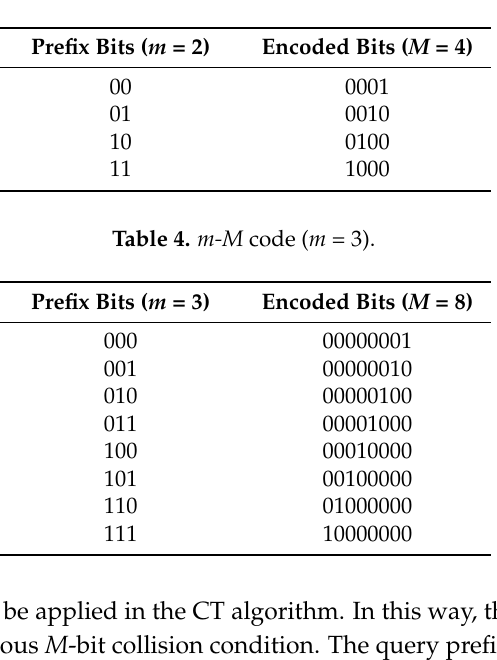
Table 3. m-M code ( m = 2).